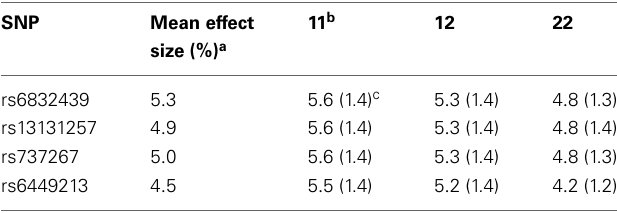
Table 2 | Association of the most significant SNPs in solute carrier protein 2 family, member 9 ( SLC2A9 ) gene with serum uric acid (mg/dl).